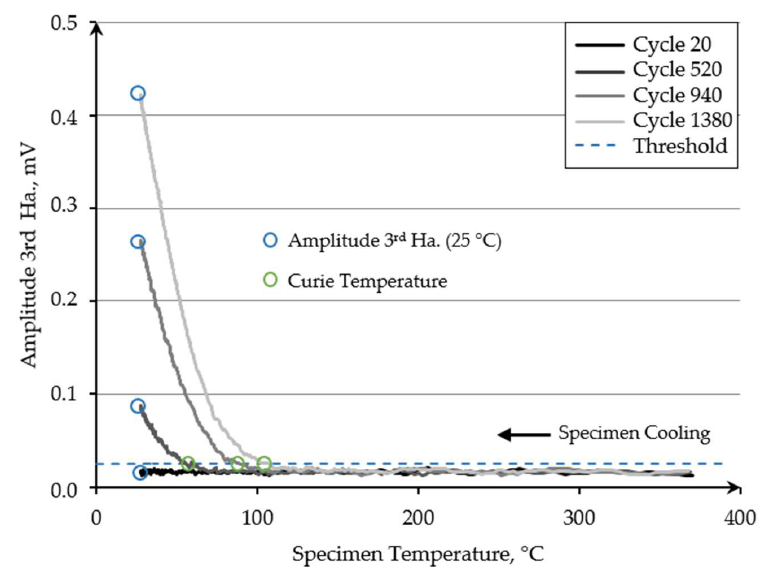
Figure 4. Amplitude of the third harmonic versus specimen temperature for selected cycles in the modified isothermal LCF test with a strain amplitude of ε mech . = 0.5 %, a strain ratio of R ε = −1 and a specimen test temperature of ϑ 1 = 800 °C .